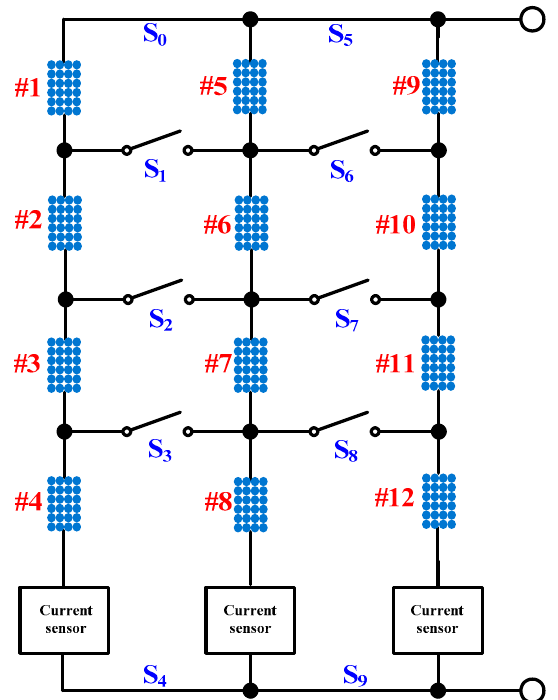
Figure 1. The presented photovoltaic (PV) module array